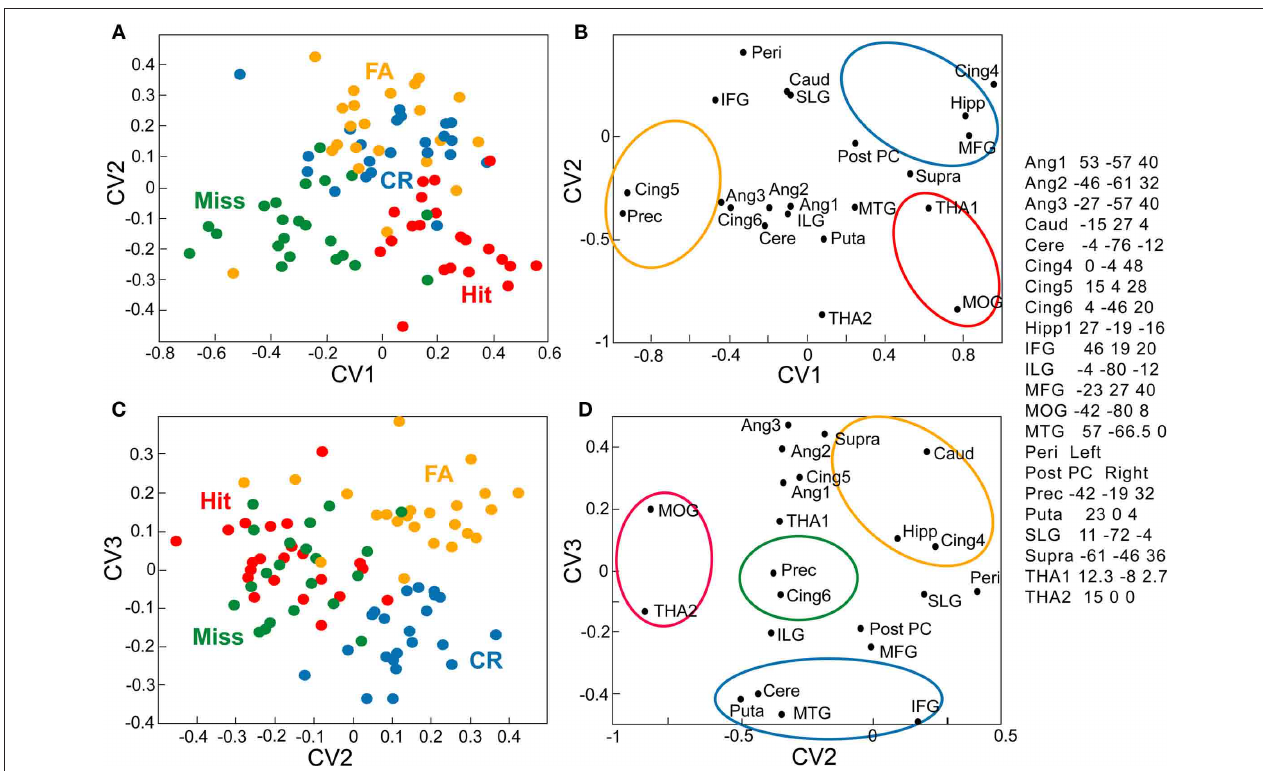
FIguRe 8 | Canonical variate analysis of activations recorded in 22 structures in 22 elderly subjects. (A,B) Planes defined by CV1 and CV2. (C,D) Planes defined by CV2 and CV3. Ang, angular; Caud, caudate; ILG, inferior lingual gyrus; Puta, putamen; SLG, superior lingual gyrus; THA. Mean of two or three ROIs in the thalamus. See Figure 7 for details and other abbreviations.